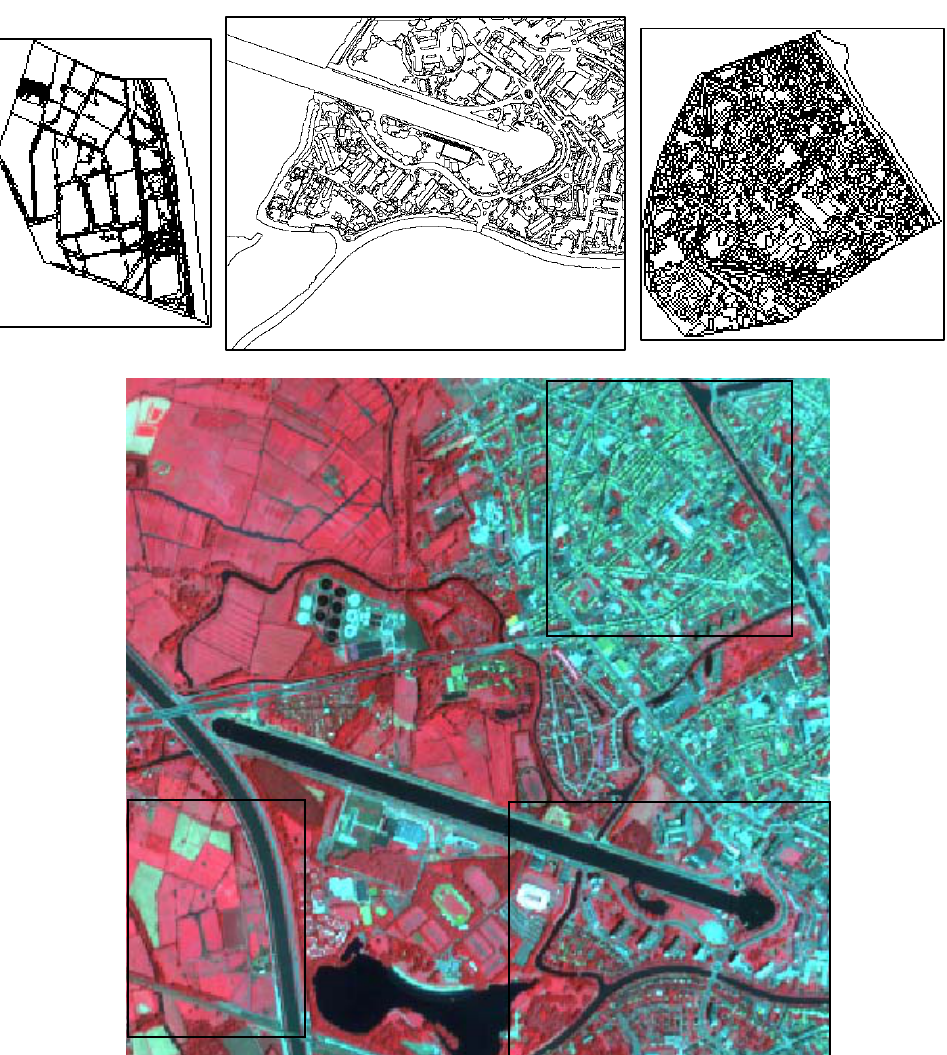
Figure 1. False colour infrared image of the study area (bottom) showing the spatial extent of the three ground truth sites